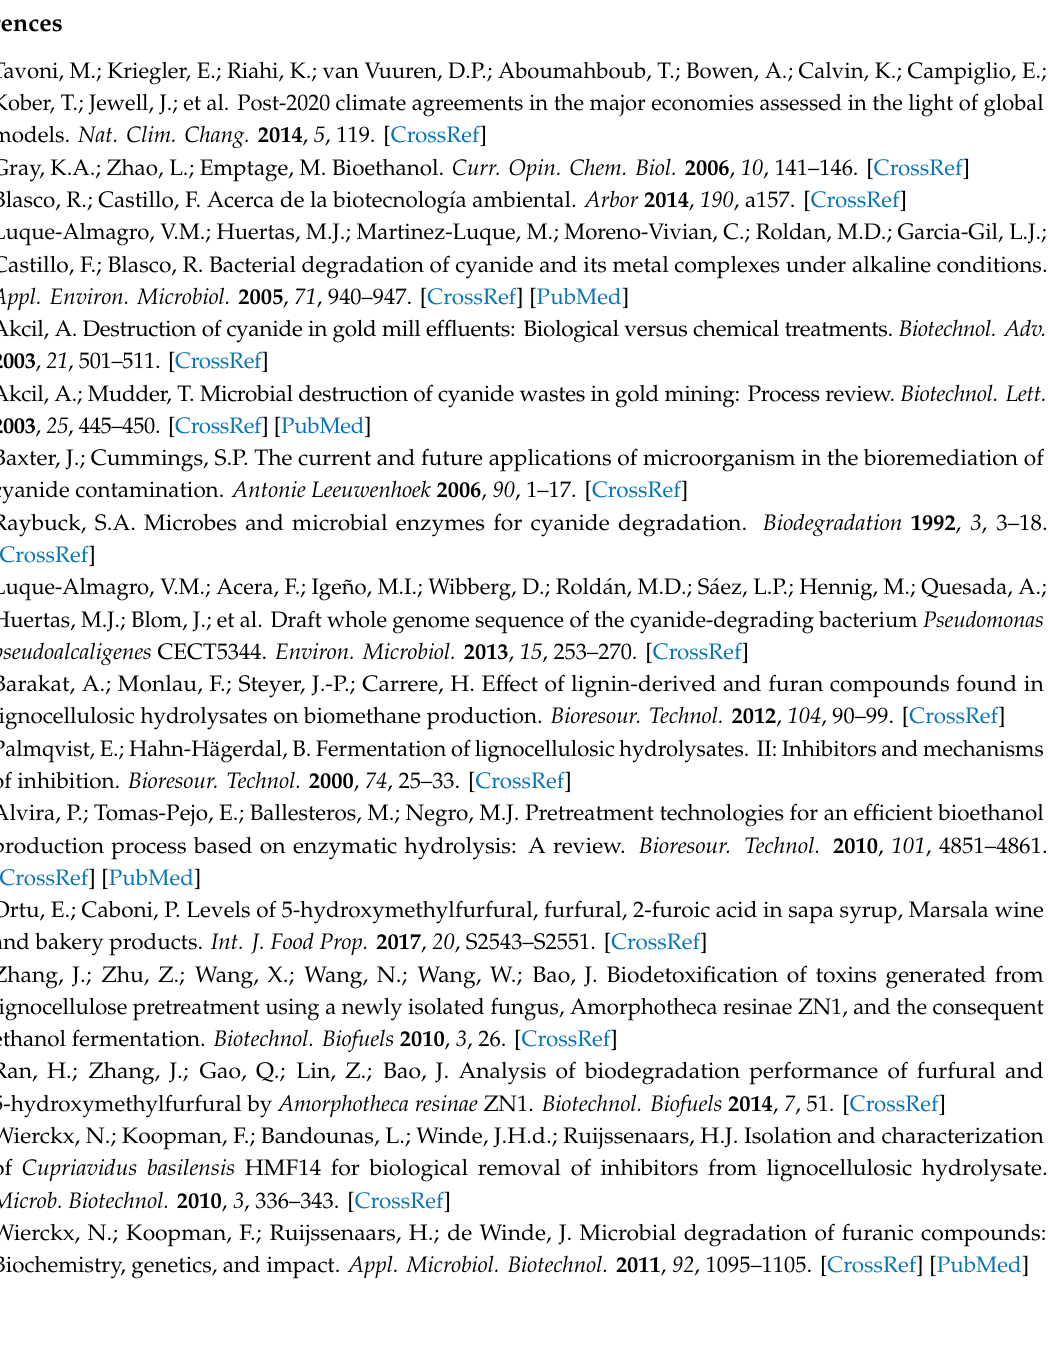
Figure S1: Schematic construction of PGEM-TE edd aacC1 plasmid. Figure S2. Schematic construction of PGEM-TE araC aacC1